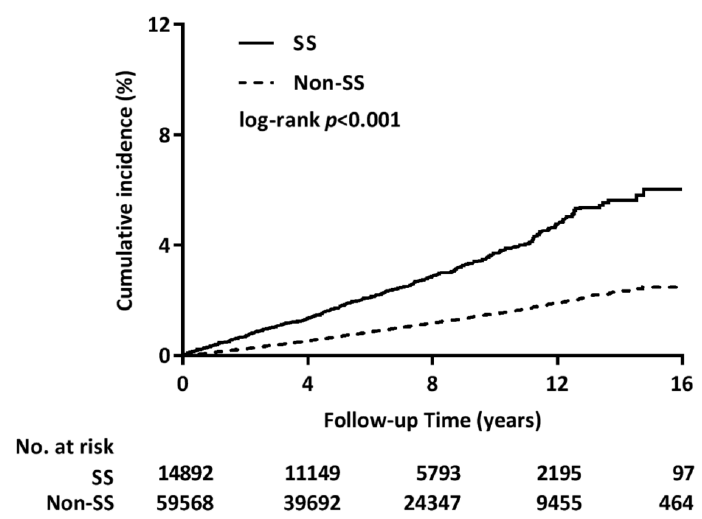
Figure 2. Cumulative incidence of CRS in patients with and without SS. SS, Sjögren’s syndrome. Patients with SS had a significantly higher cumulative incidence of chronic rhinosinusitis than those without SS. Table 2. Multivariable cox proportional hazard model of association between chronic rhinosinusitis and Sjögren’s